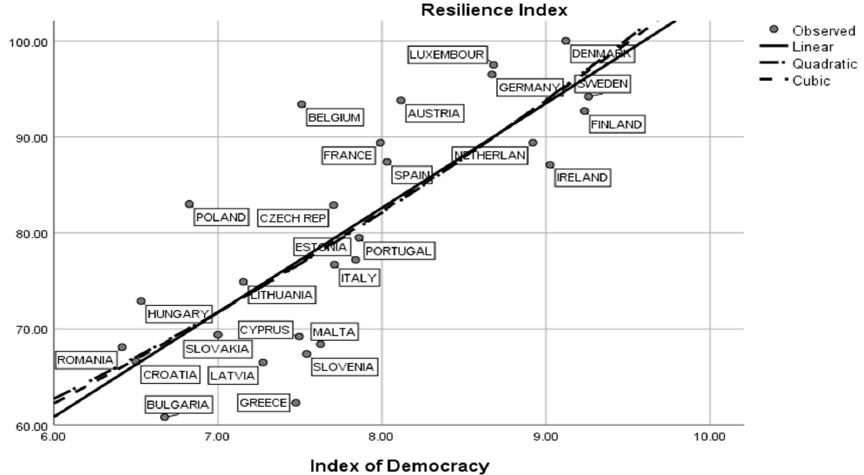
Figure 5. Correlation between Democracy Index and Resilience Index. Author’s quantitative deter- mination based on statistical data presented in Section 2 (Research Methods). mination based on statistical data presented in Section 2 (Research